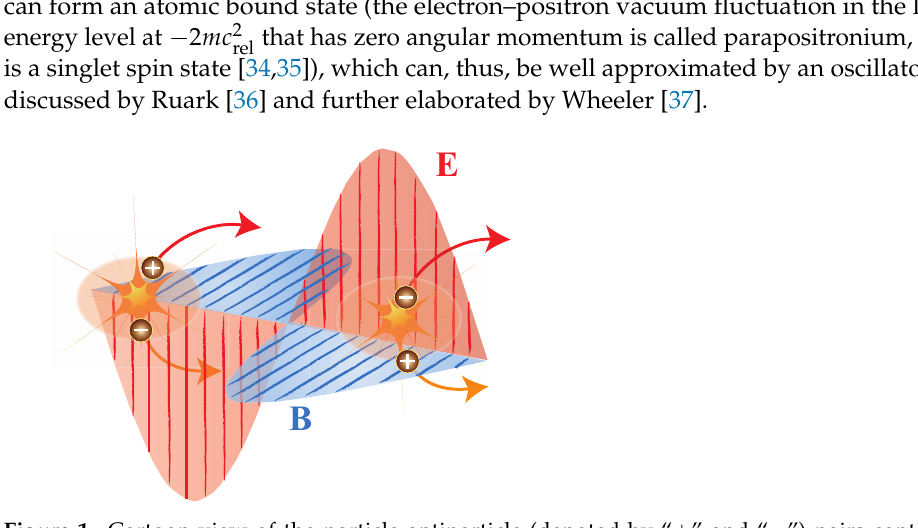
Figure 1. Cartoon view of the particle-antiparticle (denoted by “ + ” and “ − ”) pairs continually created in the vacuum. The arrows indicate the trajectories of the corresponding particles. See text for more